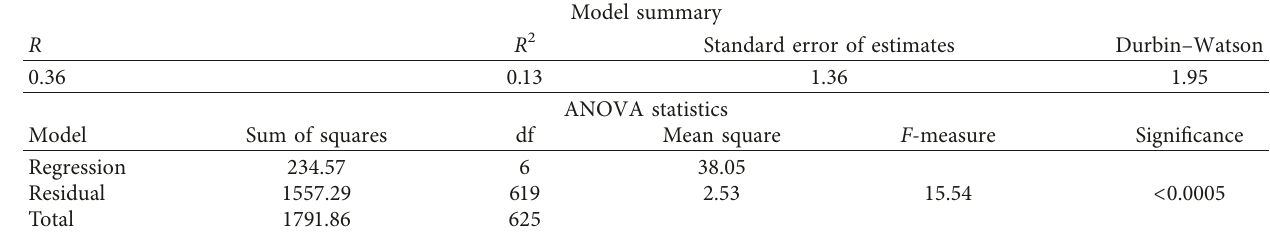
Figure 2: Scatterplot of regression standardized Table 4: Model summary and ANOVA statistics.